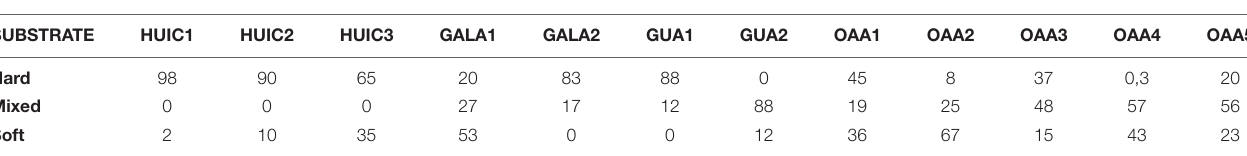
FIGURE 1 | Map of study area in the Aysén Region showing the MAs (blue circles) and OAAs (red circles) sampled between January and April 2016. TABLE 1 | Substrate type (% of the total surface area) in each area